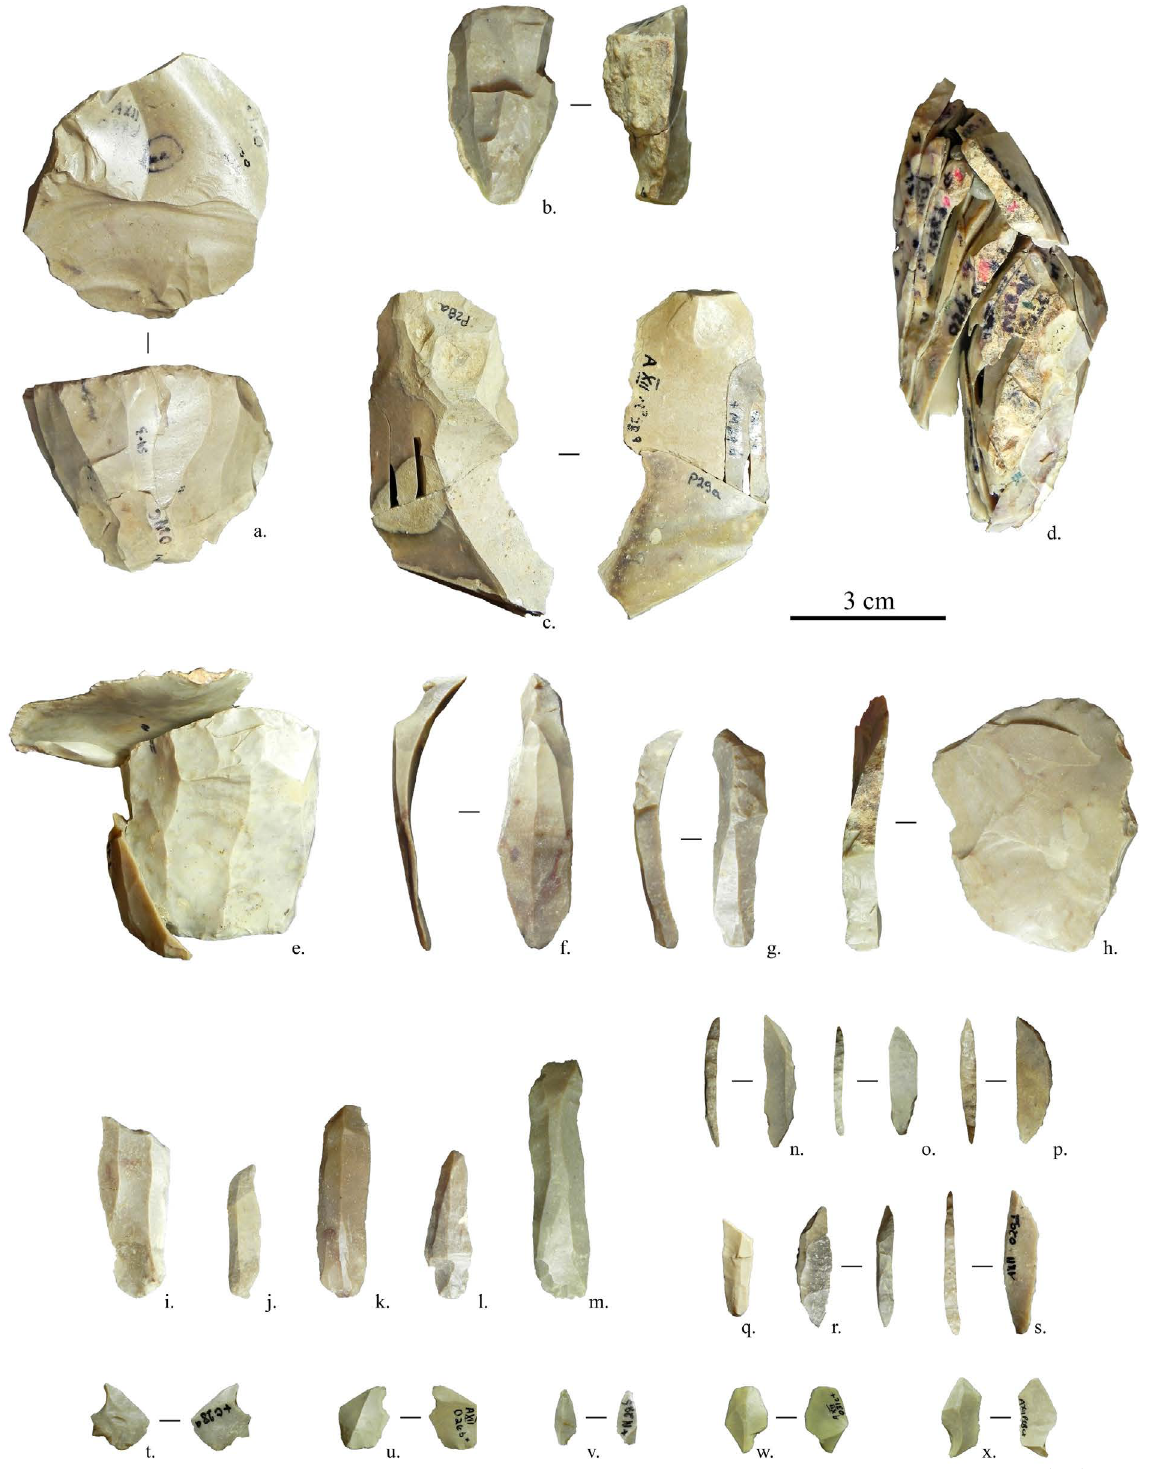
Figure 6. Azariq XII - lithic artefacts. a ,b, d, e = cores, c = refitted burin on a break on a flake, (f-h) core trimming elements, (i-m) elongated blanks, (n-s) arch-backed scalene bladelets, (t-x)